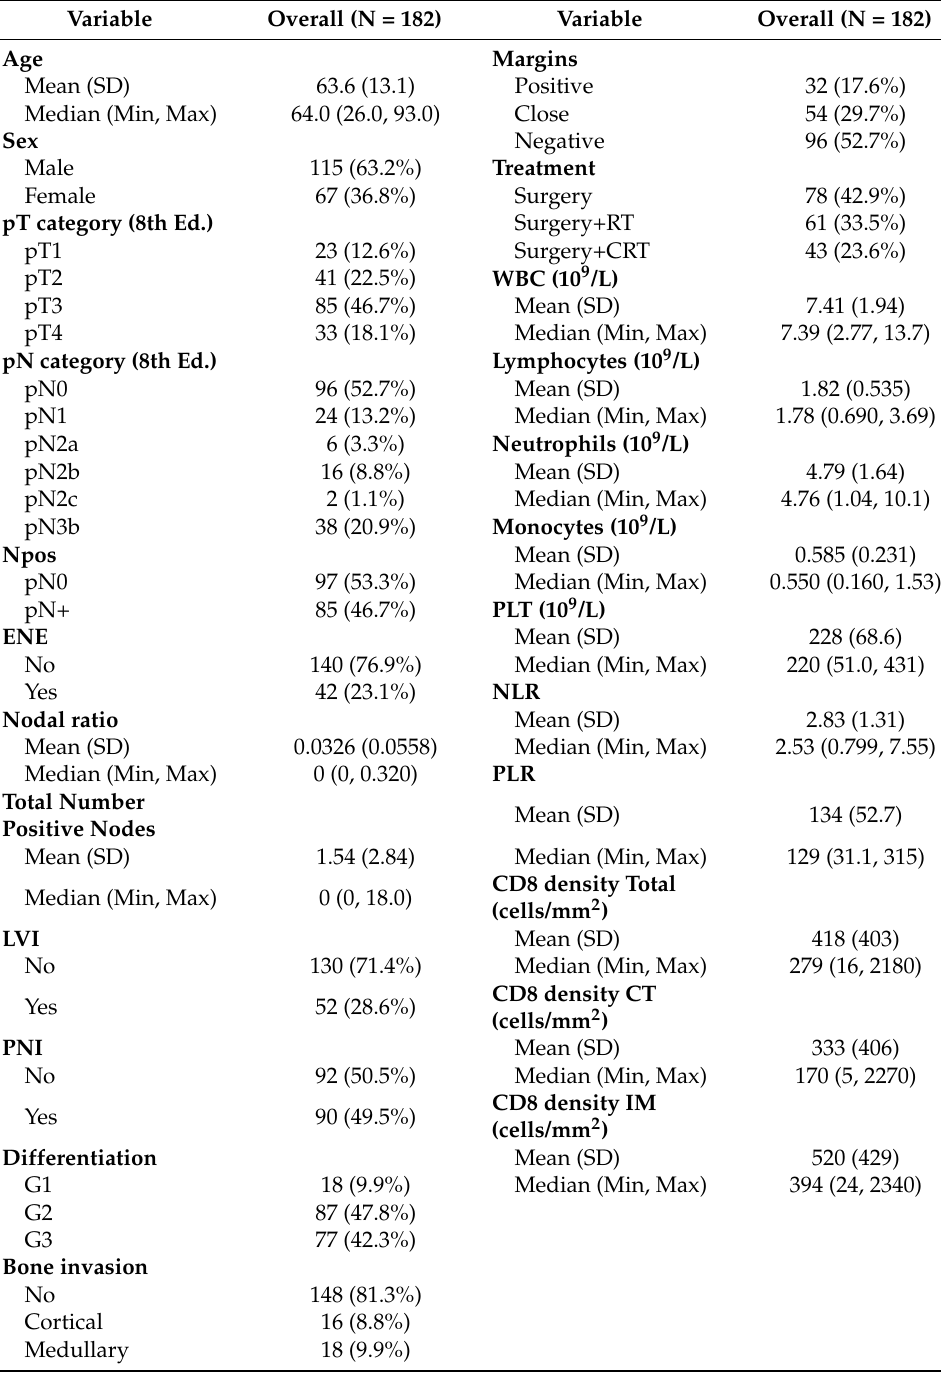
Table 1. Summary statistics of the